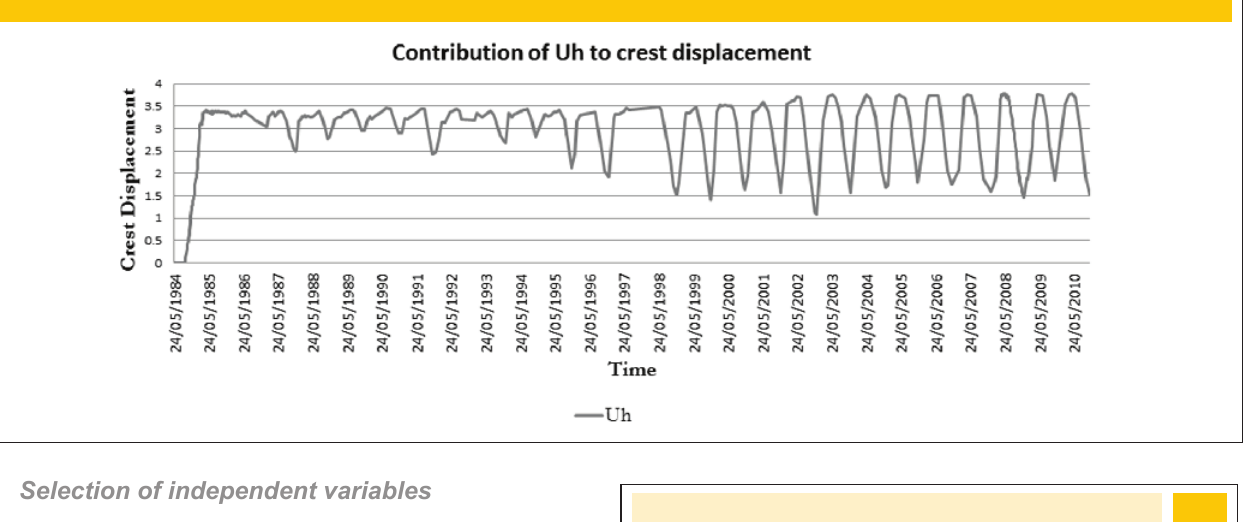
Figure 1 – Contribution of the upstream level to displacement of the dam